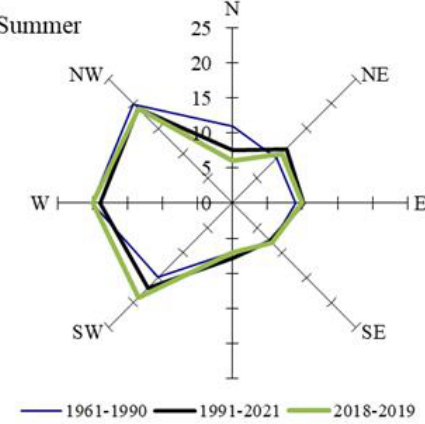
Figure 7. Dominant winds during the summer on the southeastern coast of the Baltic Sea (in situ data from the coastal meteorological station, Klaipeda).